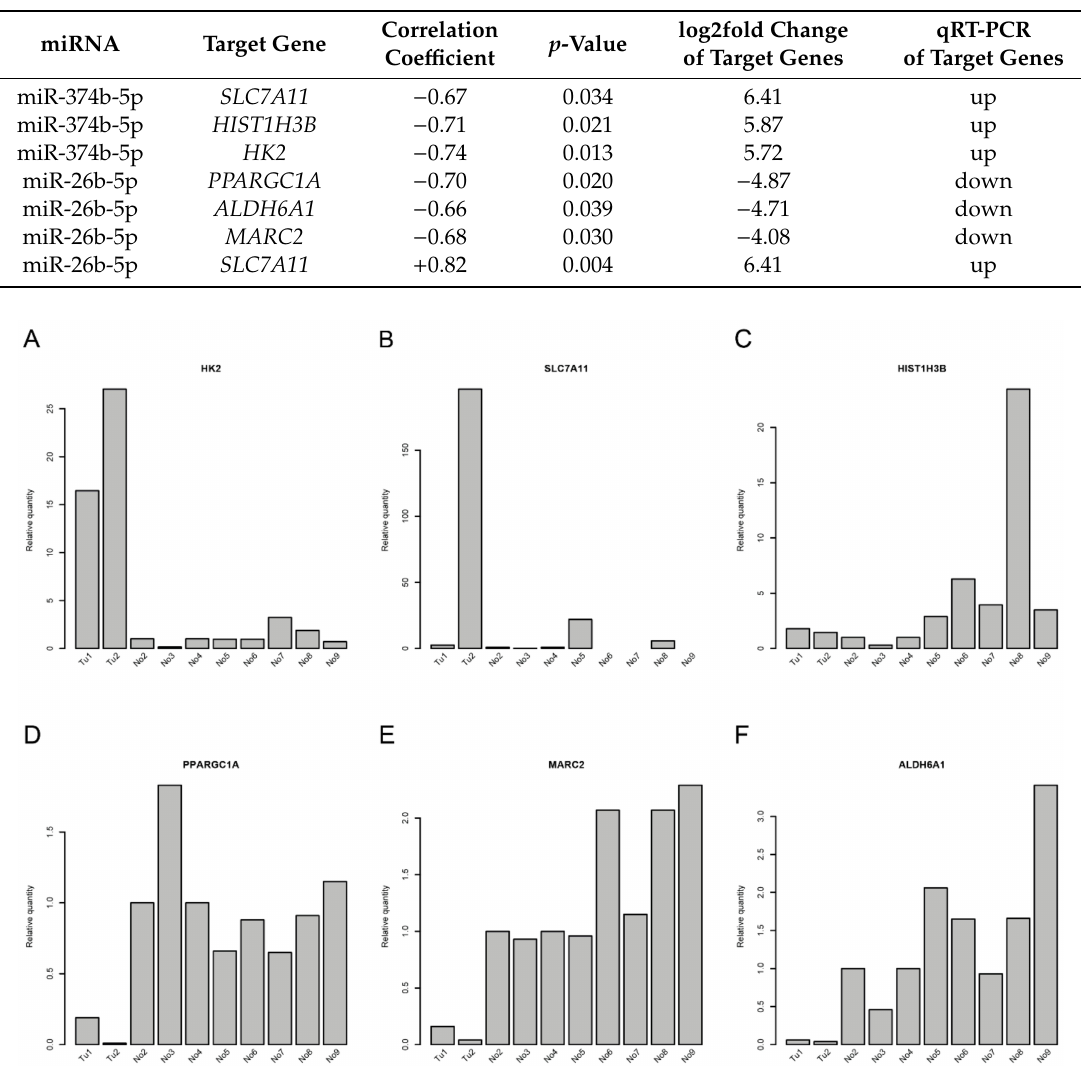
Table 1. Computational correlation analysis of miRNAs and their target genes.